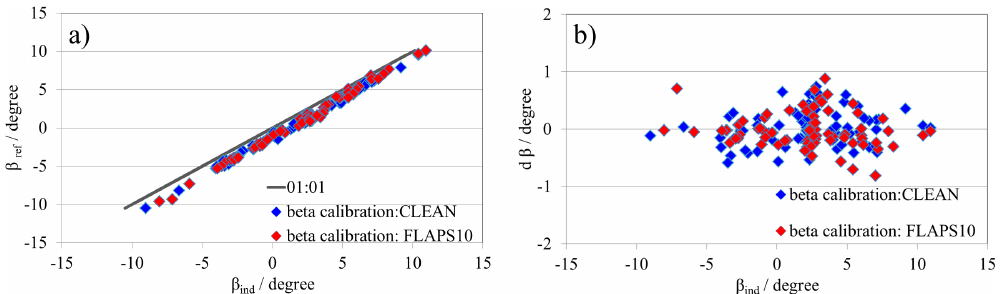
Figure 7. (a) Comparison of β ind with the measured reference values β ref which are calculated from Eq. (16) for 159 test points during four calibration flights. (b) Difference between the corrected β values and the reference values ( β ref ). A linear fit is performed with the results shown in (a) to correct the sidewash effect for all the test points. The scatter of the results is due to short-time changes of the wind speed during the calibration manoeuvres.